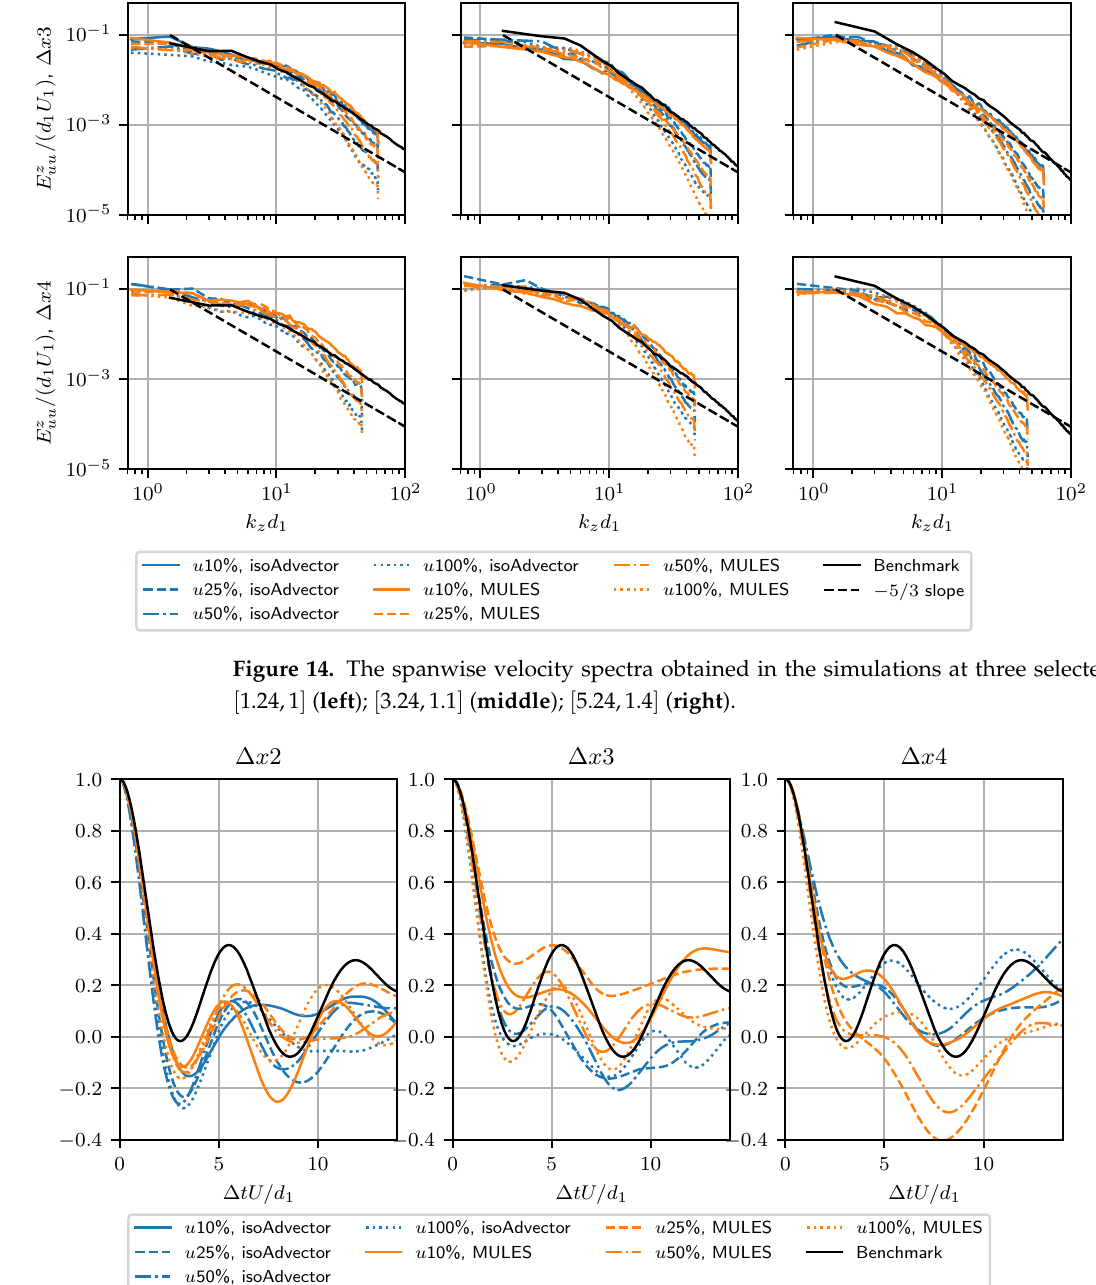
Figure 15. The obtained autocorrelation functions of the volume of leaked